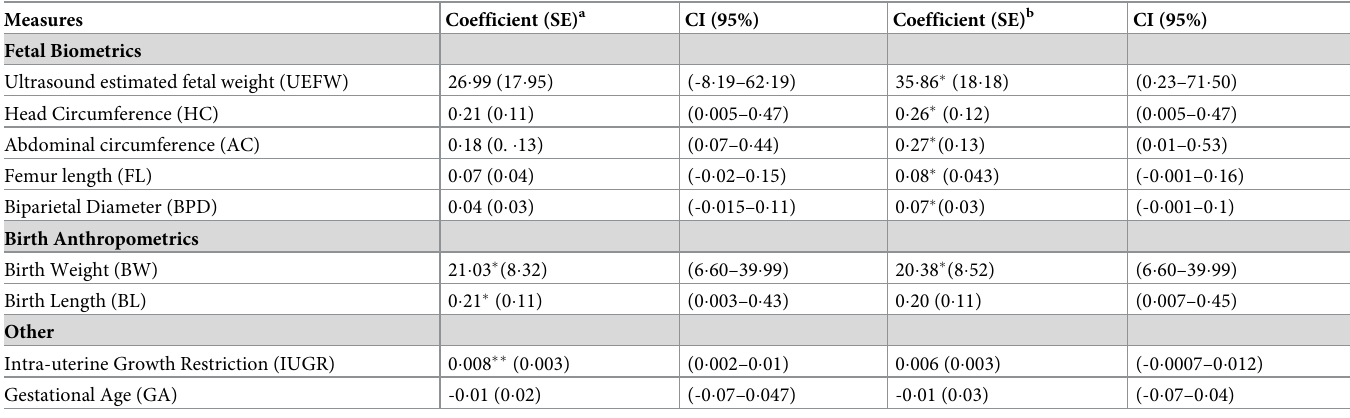
Table 3. Multivariate analysis showing association between PMPD and